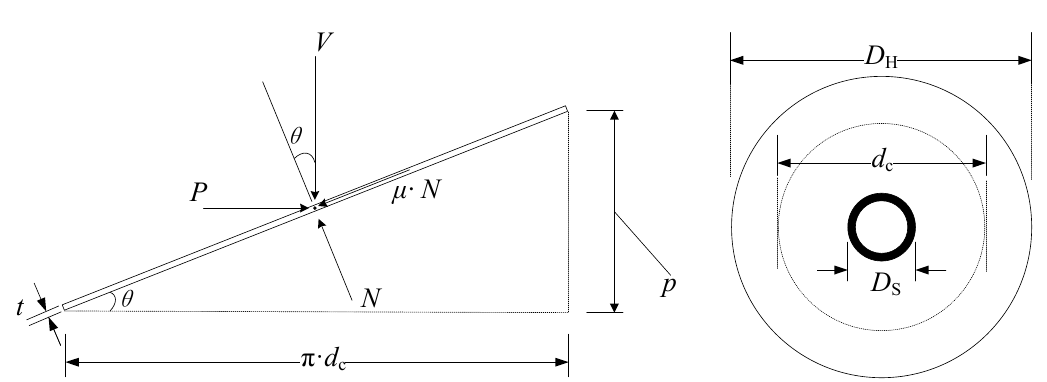
Figure 2. The vertical force acting on helix.